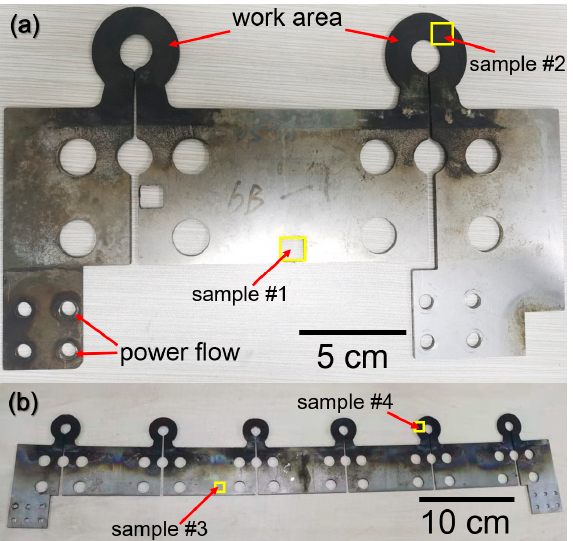
Figure 1. Photos of medical thermal packaging heater band after long-term heat treatment ( a ) sam- ple #1 and #2; ( b ) sample #3 and #4. #1 and #2; ( b ) sample #3 and